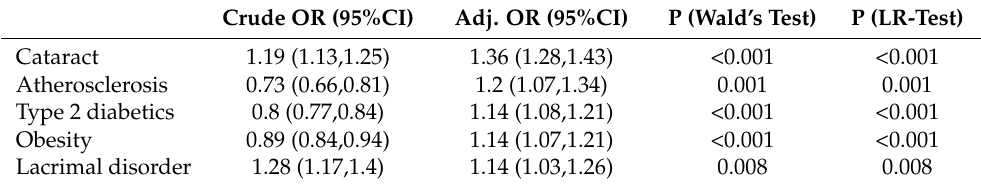
Table 4. Adjusted odds ratio analysis—1-year data presented only with OR 1.14 and above. Crude OR (95%CI) Adj. OR (95%CI) P (Wald’s Test) P